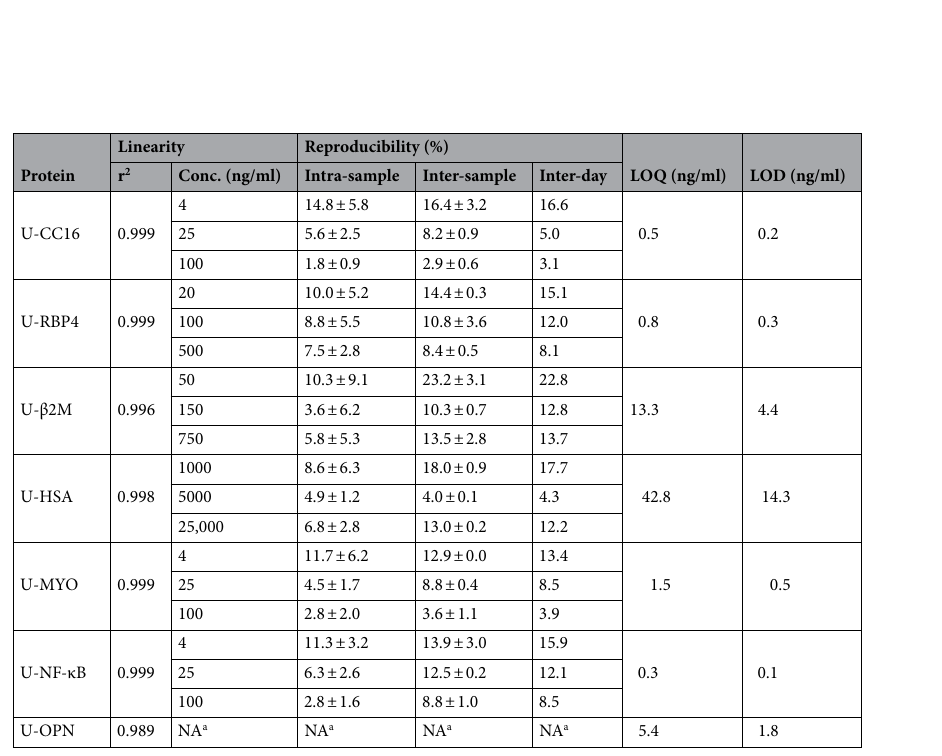
Table 2. Overview of the linearity, reproducibility, LOD and LOQ obtained for each protein. a Due to the high costs needed for obtaining the required amounts of the OPN protein to mimic its abundant presence in urine (U-OPN), it was not possible to do a complete method validation. Conc . Concentration, NA not available, LOD limit of detection, LOQ limit of quantification. The linearity is determined by r 2 of the curve for the specified concentration range (ng/ml). The reproducibility is characterized by a coefficient of variance (%) ± standard deviation. The LOD and LOQ are derived from the signal-to-noise ratio and are expressed in